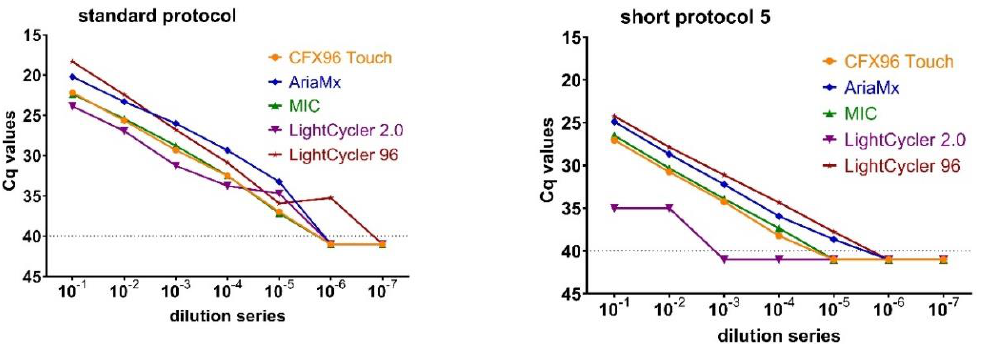
Figure 4. Device test with five qPCR cyclers: differences in Cq-values of the standard and short protocol 5 for the Polci-mix.